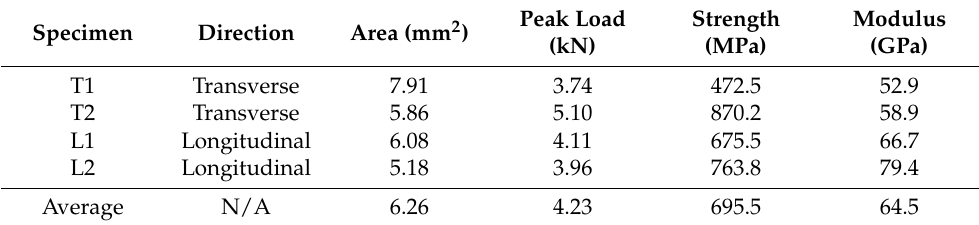
Table 1. Experimental results for CFRP grid specimens